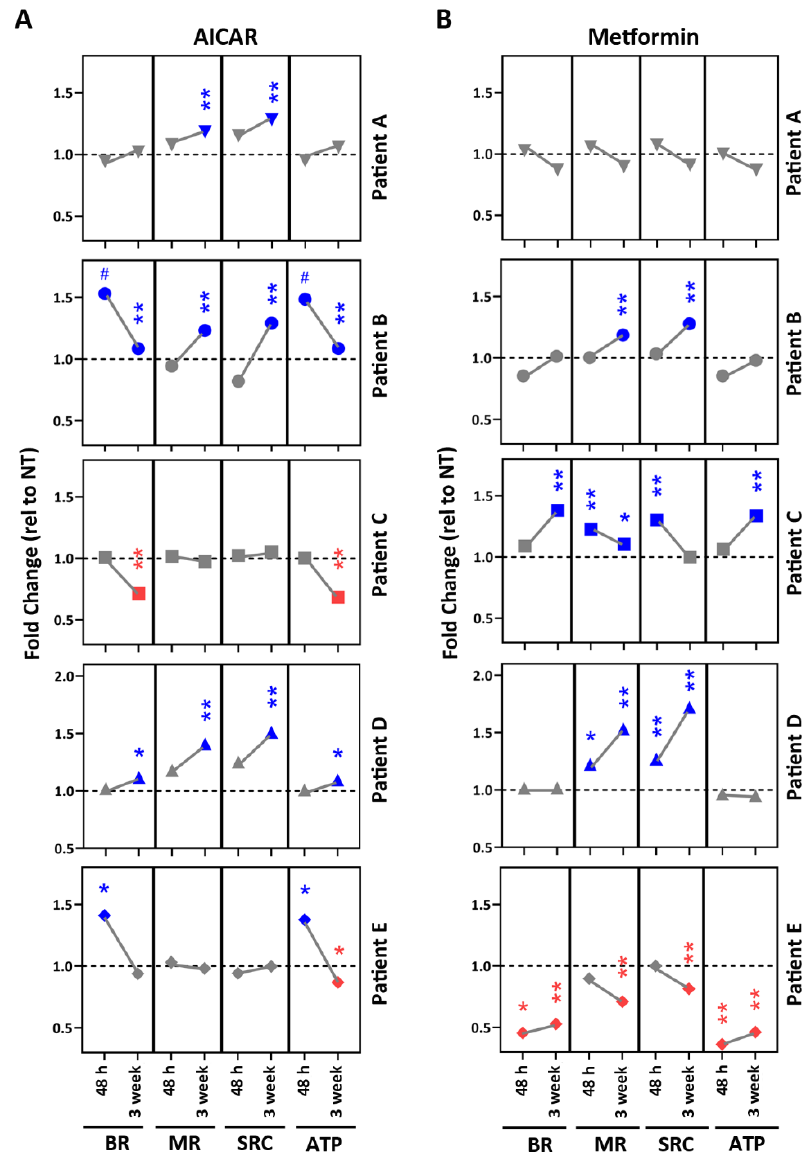
Figure 5. Testing AMPK activators using patient-specific iPSC-RPE. In two separate experiments, iPSC-RPE cells from patients with AMD ( n = 5) were treated with ( A ) AICAR or ( B ) Metformin for 48 h or 3 times per week for 3 weeks. Following treatment, parameters of mt function were calculated from OCR measured using an XFe96 Extracellular Flux Analyzer. OCR data were normalized to cell count per well. Graphs show fold change relative to each donor’s no- treatment control (dashed line). Blue data points indicate response from cells that exhibited improved mt function. Red data points indicate response from cells that exhibited decreased mt function. BR = basal respiration; MR = maximal respiration; SRC = spare respiratory capacity; ATP = ATP-linked respiration. * p < 0.05, ** p < 0.01, # p < 0.1 determined by unpaired t -tests of raw OCR values (average no treat OCR vs. average treatment